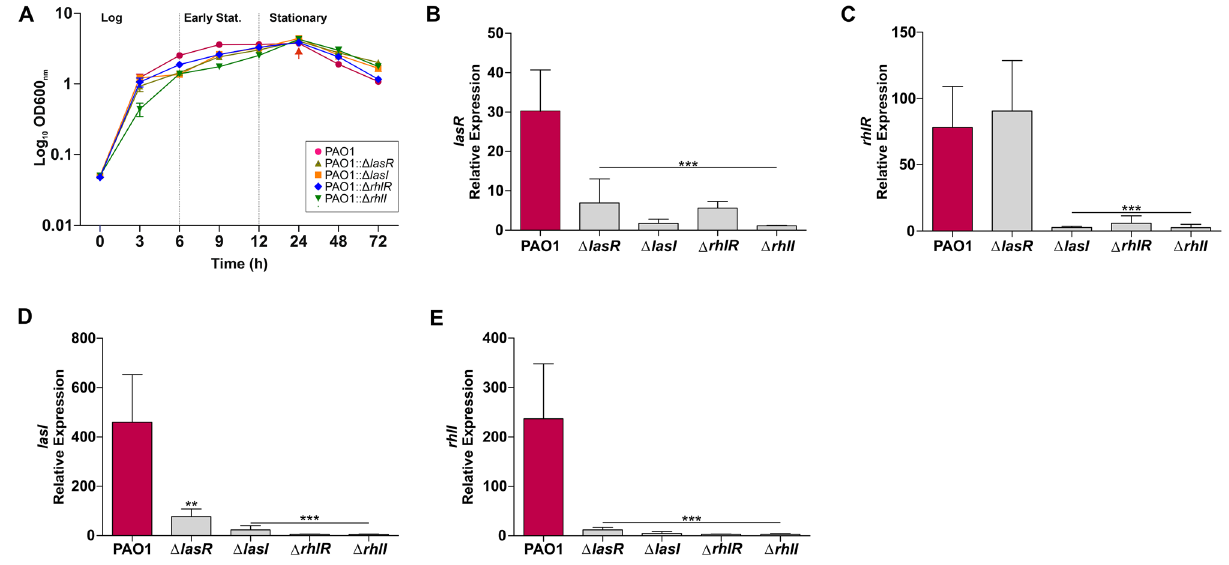
Figure 3. Inactivation of QS regulatory genes reduces both las and rhl QS systems. ( A ) Growth phenotypes of PAO1 and isogenic QS regulatory mutants in a phosphate limited media (PPGAS). Relative expression levels of QS regulatory genes ( B ) lasR, ( C ) rhlR, ( D ) lasI, and ( E ) rhlI in both PAO1 and QS mutants. Relative expression levels were quantified in the stationary phase (indicated by red arrow) of growth by qRT-PCR. Error bars represent S.D. ± (n = 3 biological replicates). All mutant data was analysed relative to PAO1 expression values. Significance was determined by a one-way ANOVA followed by Dunnett’s multiple comparison test (* p < 0.05, ** p < 0.01, *** p < 0.001).